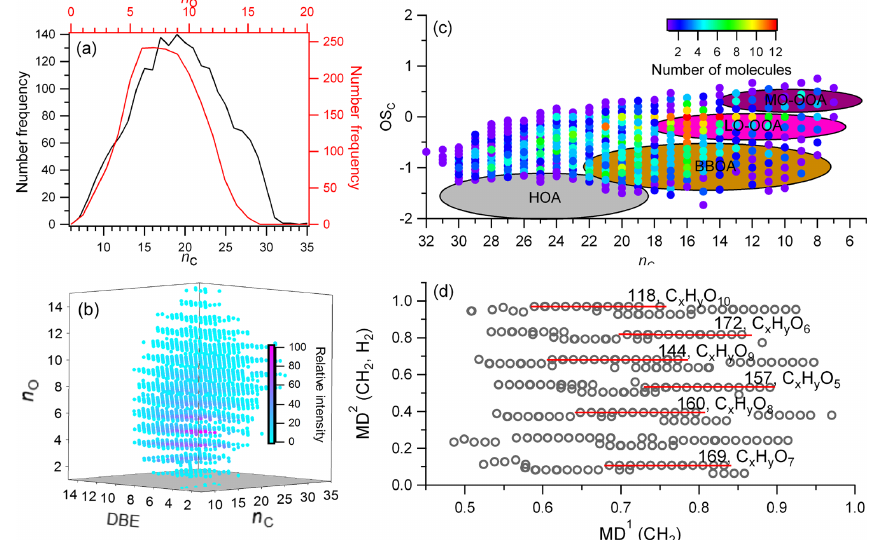
Figure 4. The molecular information for common CHO compounds. (a) The number frequency distribution of carbon ( n c ) and oxygen ( n o ). (b) The 3-D plot for n o , n c , and double bond equivalents (DBEs) colored by their relative intensity. (c) Scatter plot of carbon-based oxidation state (OSc) vs. n c colored by the distribution of number of molecules. (d) The second-order mass defect analysis (MD 2 (CH 2 , H 2 ) vs. MD 1 (CH 2 )) using the base of CH 2 and H 2 . The longest homologous series are marked with the group number and formula type.